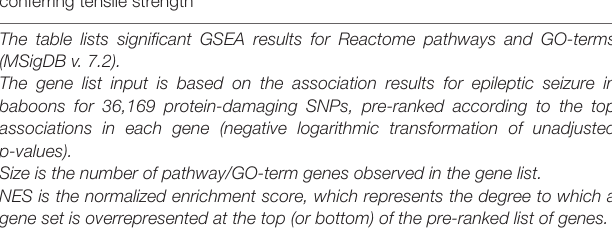
associations in each gene (negative logarithmic transformation of unadjusted